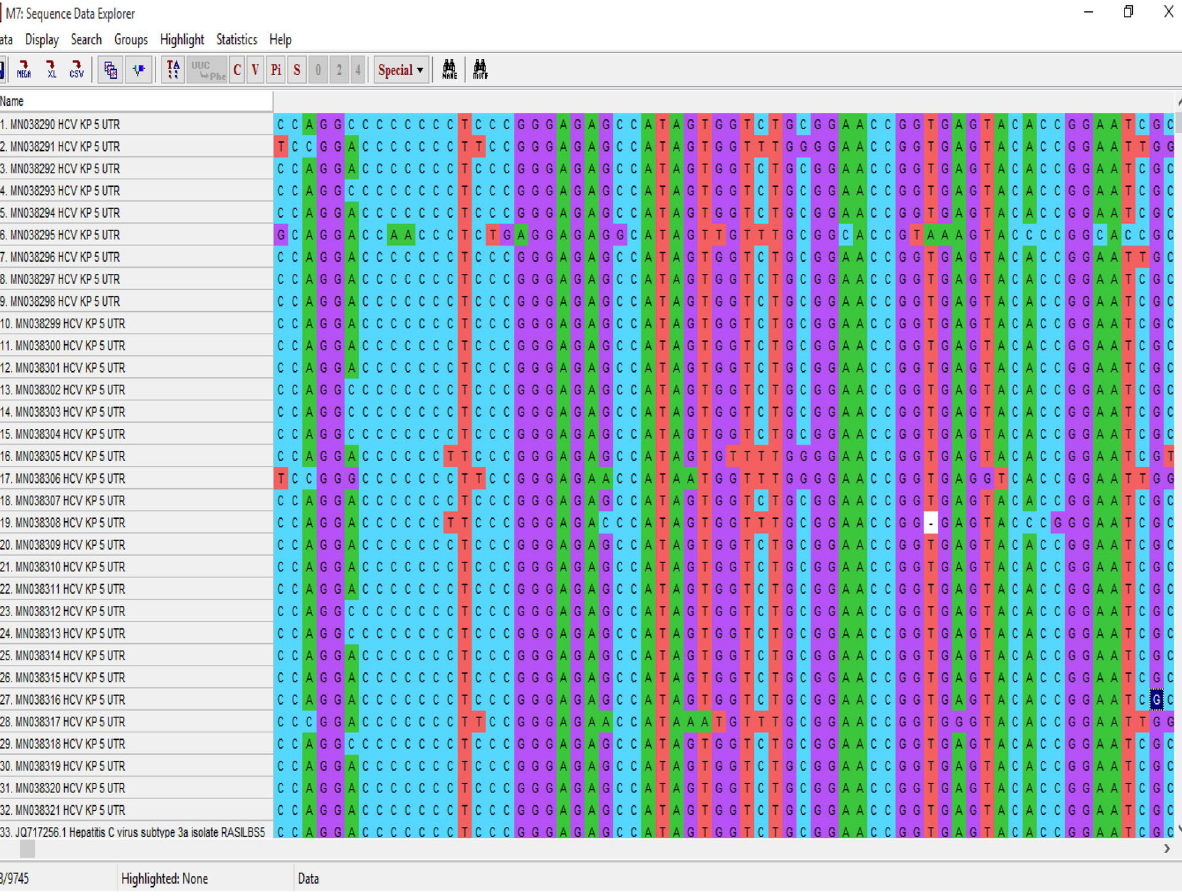
Figure 2. Alignment of the HCV 5 ʹ UTR sequence with the reference sequence